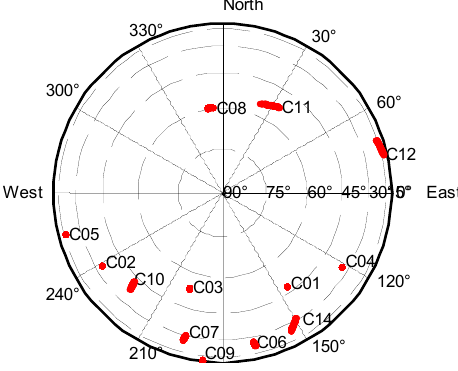
Figure 5. Distribution of BeiDou Navigation Satellite System (BDS) satellites at station TAOY.